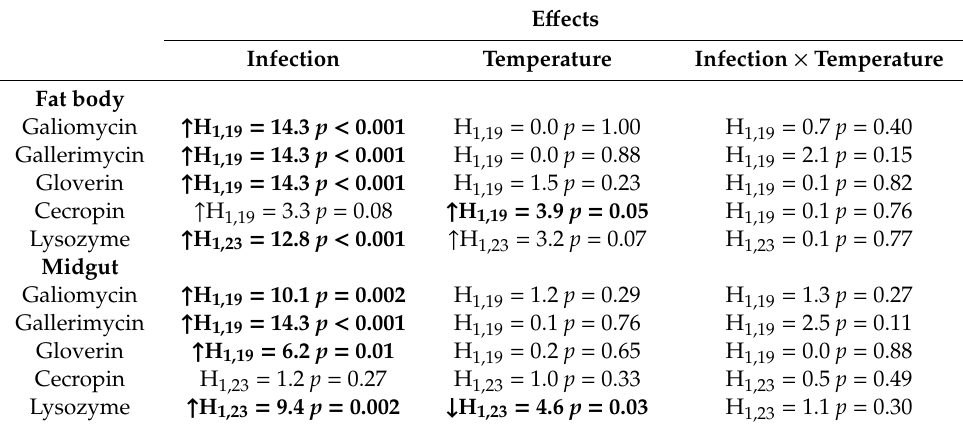
Figure 5. Relative expression of AMP genes in the fat body and midgut of wax moth larvae at 96 h after injection with С . militaris (2500 conidia per larva) and subsequent incubation at 15 °C and 25 °C. Data were normalized to the expression of two reference genes, eEF1a and RBP11. The Y -axis shows the fold change relative to uninfected larvae maintained at 25 °C. Gal —galiomycin, Glm— gallerimycin, Glo —gloverin, Cec —cecropin-like, Lys —lysozyme-like. Different letters indicate significant differences between treatments (Dunn’s test, p < 0.05). Table 1. Two-way effects of C. militaris infection and temperature on the expression of AMP genes. Significant effects are highlighted in bold. Arrows show up- or downregulation of genes in response to infection and in response to cooling to 15 degrees. Arrows are shown only for significant ( p < 0.05) and marginal ( p = 0.05–0.10) effects.